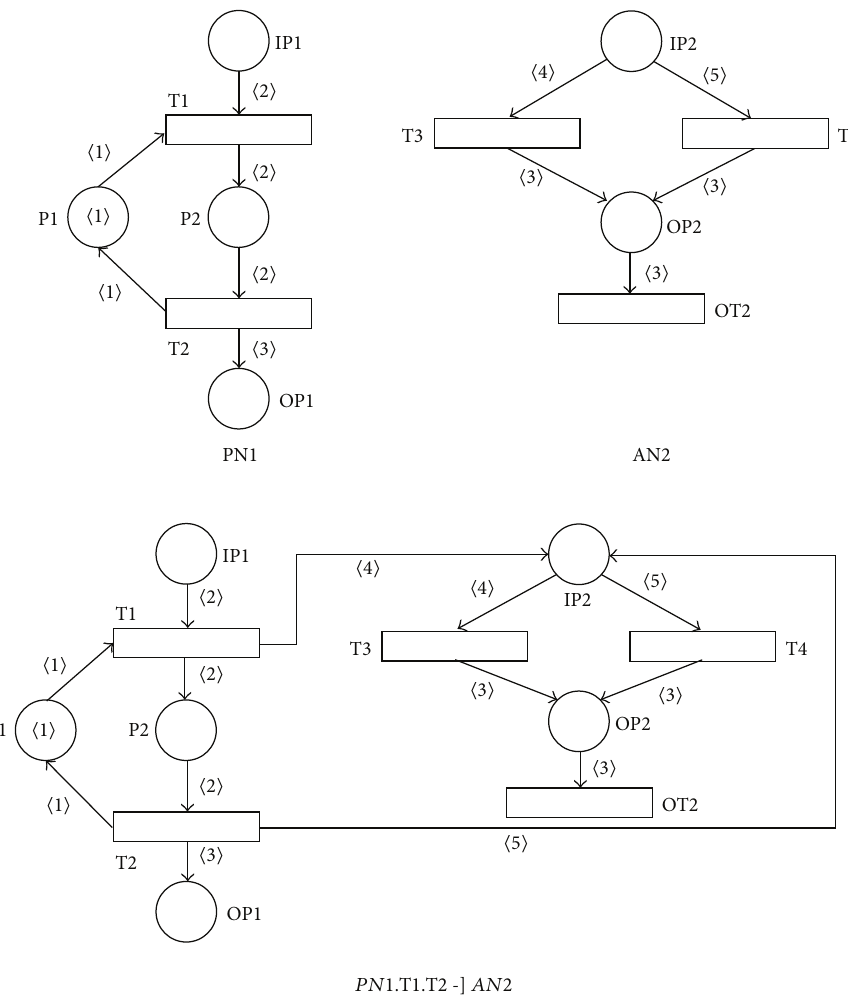
Figure 10: Result of asynchronous-processing operation 𝑃𝑁1. T1 . T2 - ] 𝐴𝑁2 .